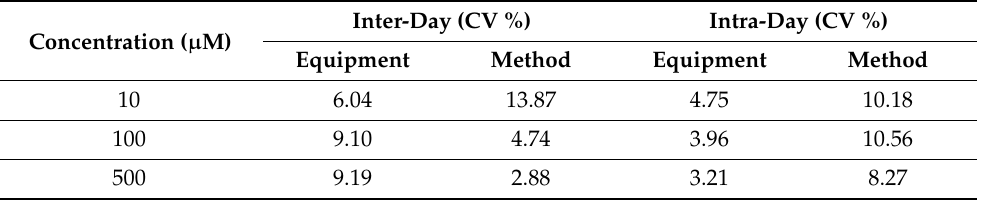
Table 3. Inter-day and intra-day precision data.